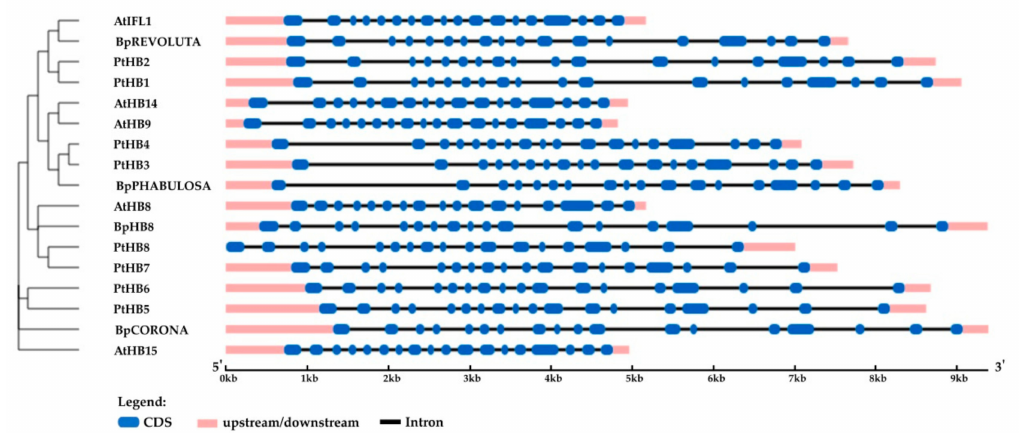
Figure 12. Structure of B. pendula , A. thaliana and P. trichocarpa HD ZIP III genes. Intron, exon, and untranslated regions (UTR) are represented by black lines, dark blue boxes, and pink